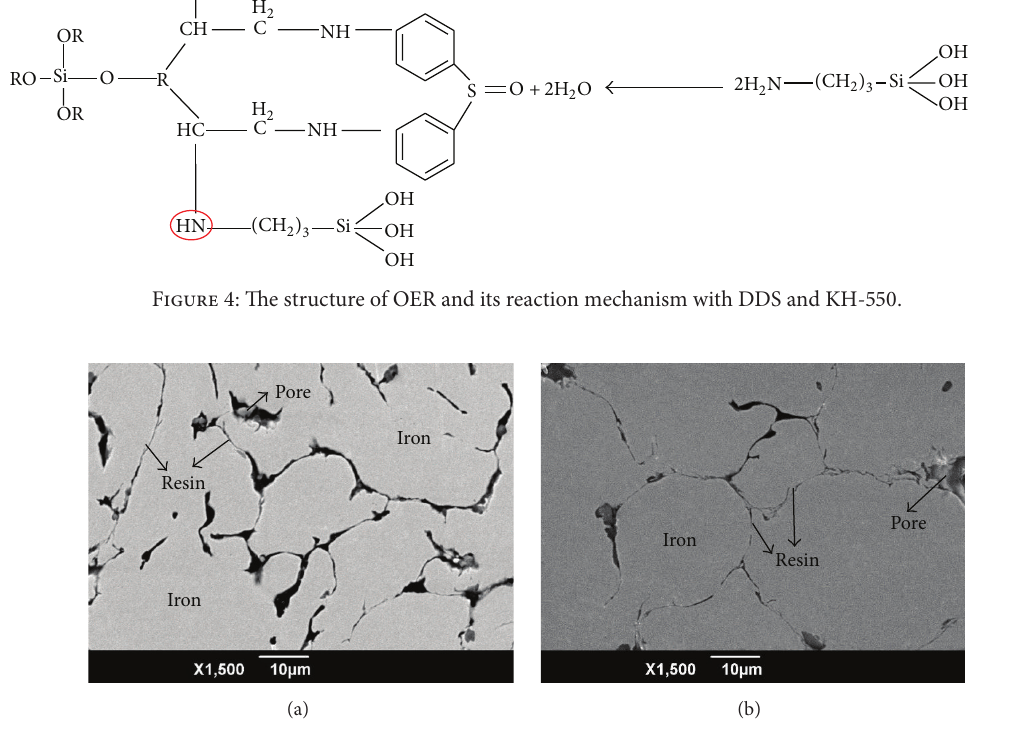
Figure 5: SEM micrograph of SMCs: (a) 200 ∘ C for 2h and (b) 130 ∘ C for 1h + 200 ∘ C for